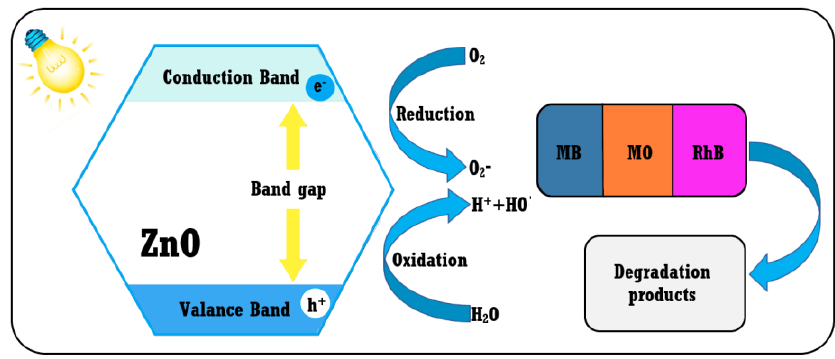
Figure 11. Photocatalytic activity against MB, MO, EY, GV and RhB for ZnO_C4 sample. The best degradation efficiency was obtained for ZnO_B sample with 99.99% for MO and RhB dyes, and 99.18% for MB. ZnO_G sample, with large hexagonal particles, still attained a degradation efficiency of 91.07% for MO, but only 74–75% for MB and RhB. These results are in good agreement with the calculated values for δ (XRD) and PL inten- sities, indicating that the surface defects are generating the ROS capable to degrade the organic compounds, and a higher defect density will lead to better photocatalytic activity. cules. Surprisingly or not, the dyes in the mixture do not behave as they do in single solu-